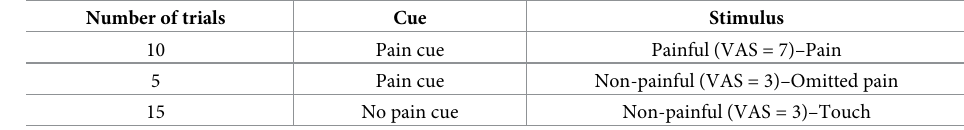
Table 1. Experimental design. Number of trials